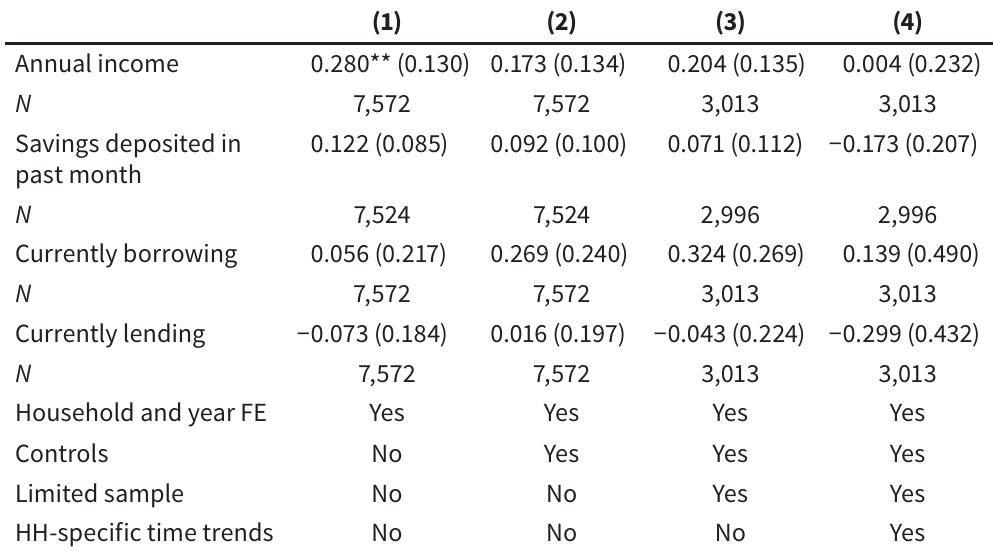
Changes in income and financial behavior ( asinh ) as the husband’s